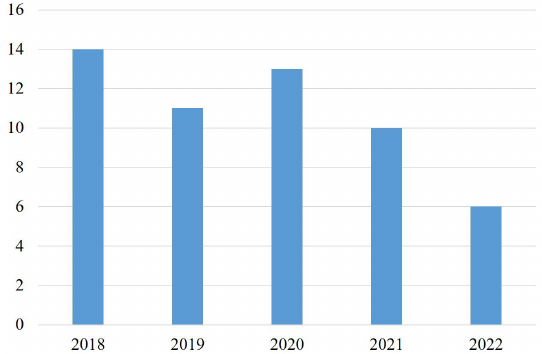
Figure 2. The annual number of published documents.